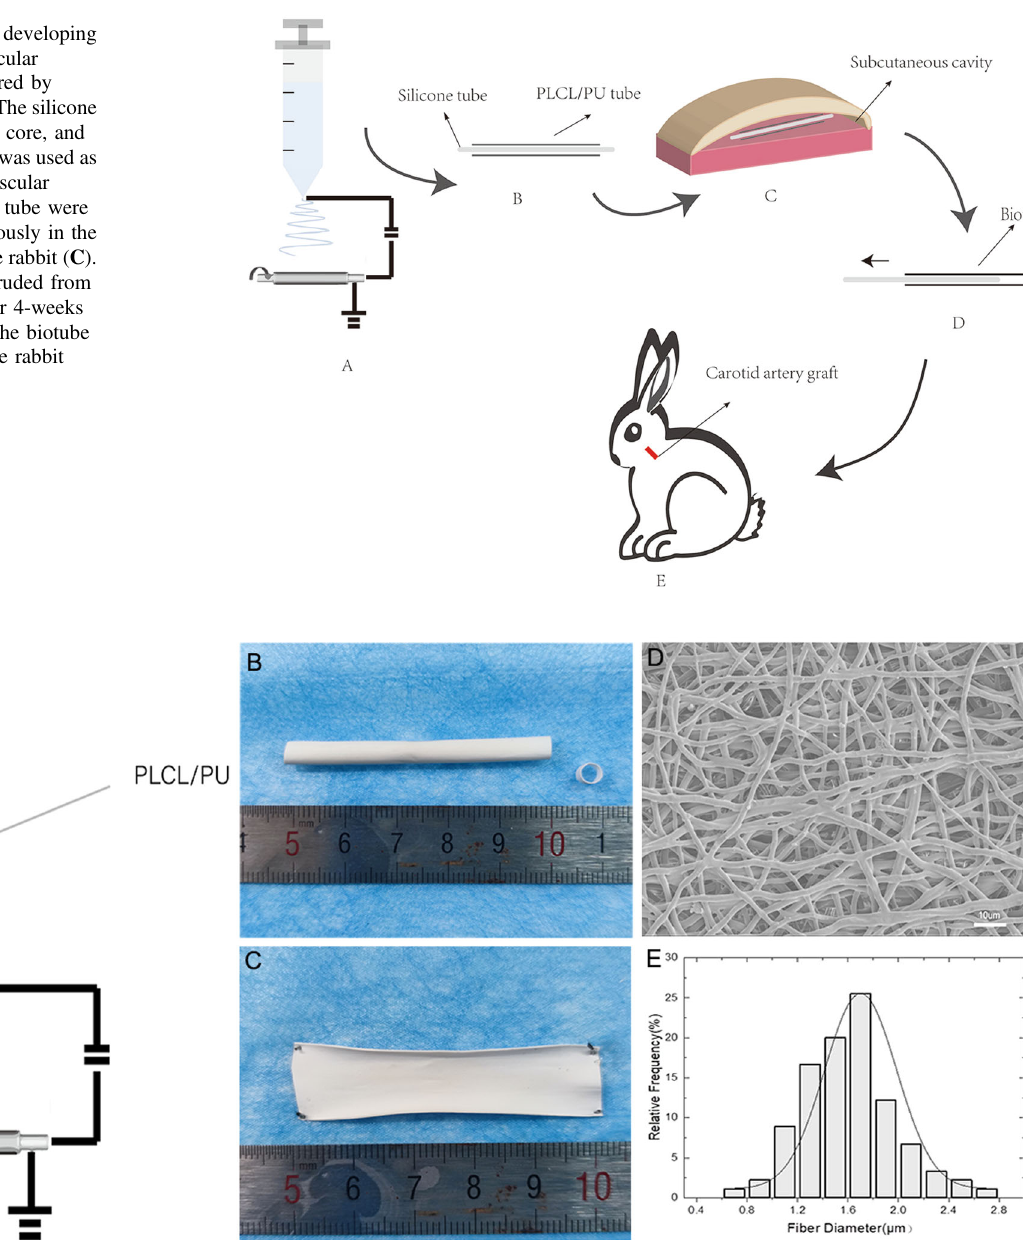
Fig. 2 Morphology characteristics of the vascular scaffold. Schematic of the process for producing the vascular scaffold ( A ). A photograph of the vascular scaffold ( B ) and the inner surface of the scaffold ( C ). The